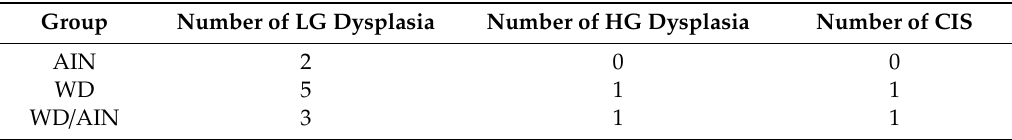
Table 1. E ff ect of the diet on the number of low-grade (LG) and high-grade (HG) dysplasias and of carcinomas in situ (CIS). Group Number of LG Dysplasia Number of HG Dysplasia Number of CIS AIN 2 0 0 WD WD / AIN 1